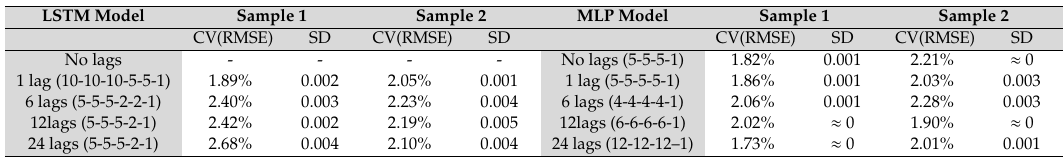
Table 3. Results of the indoor temperatures predictions based on the time lags introduced in the neural network model. LSTM errors are presented in the first three columns, whereas MLP errors are presented in the last three. The results shown summarize the 10 repetitions of the experiment, for each architecture and each sample analyzed. The mean of the CV(RMSE) obtained in each of them and the standard deviation (SD) are presented. The di ff erent structures of the neural networks that provide the best accuracy are presented between